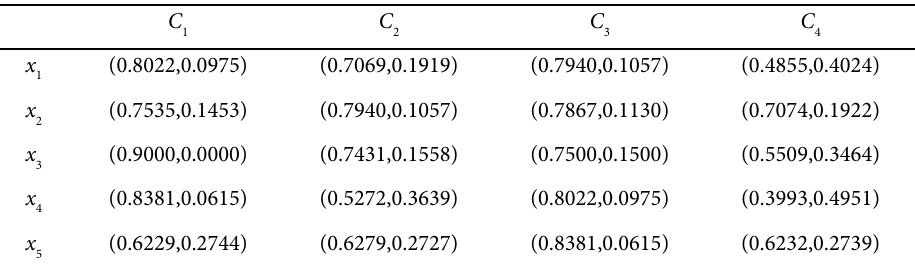
Table 5. Intuitionistic fuzzy decision matrix R ′ C